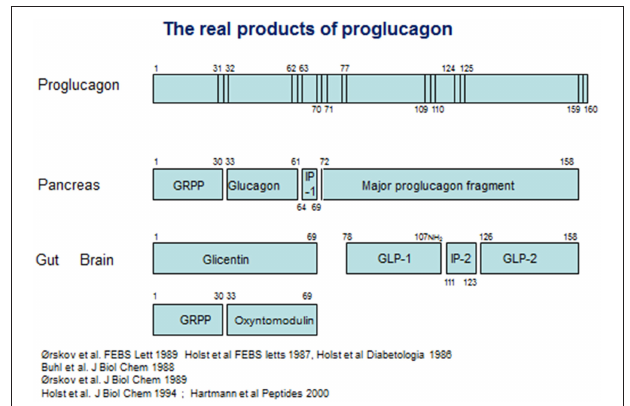
FIGURE 1 | Products of proglucagon